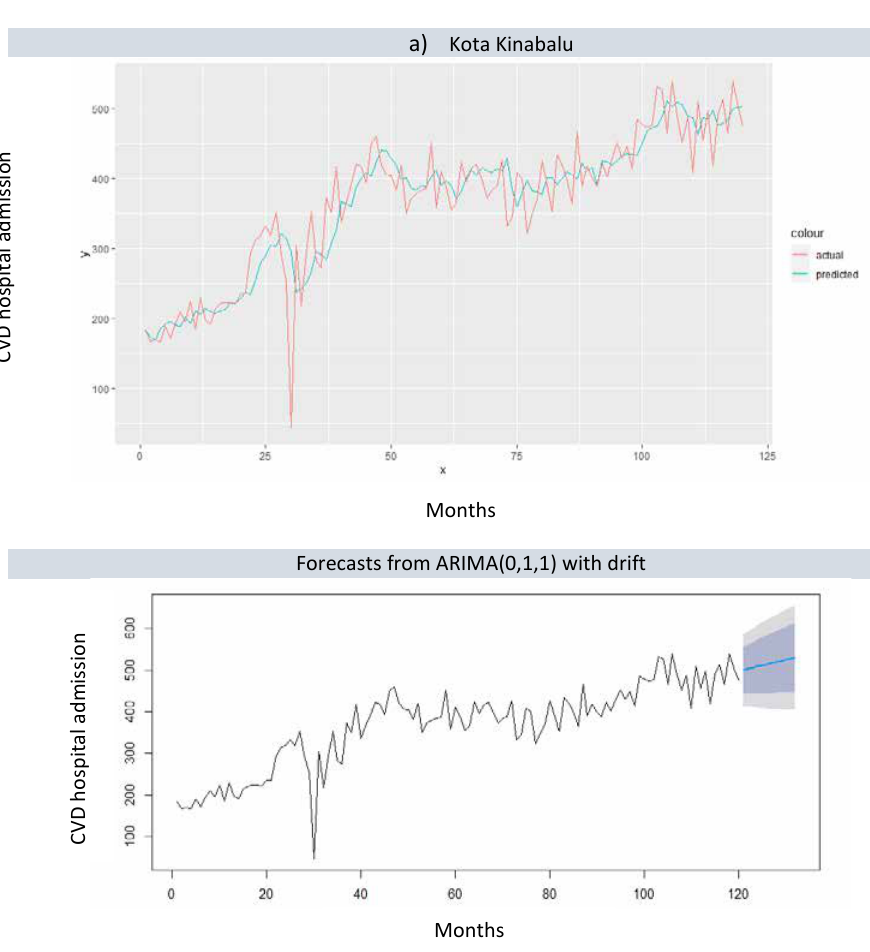
Fig. 4: Prediction forecast of cardiovascular hospital admission in Sabah with air pollutants as regressor in